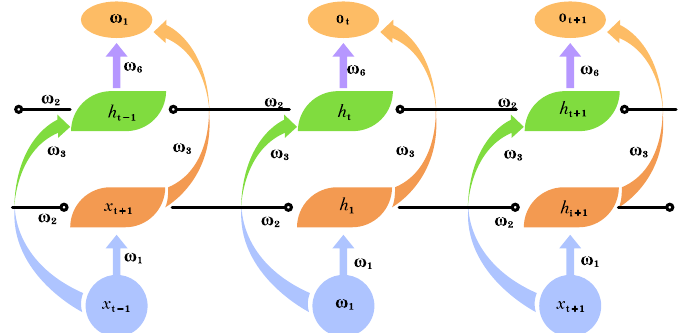
Figure 3. BI LSTM model